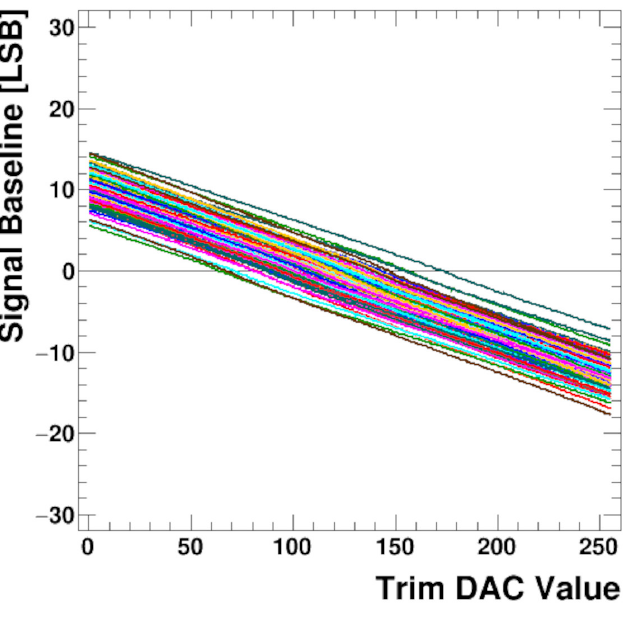
Figure 15. Baseline trim DACs scan for 128 channels after a biased UT sensor is